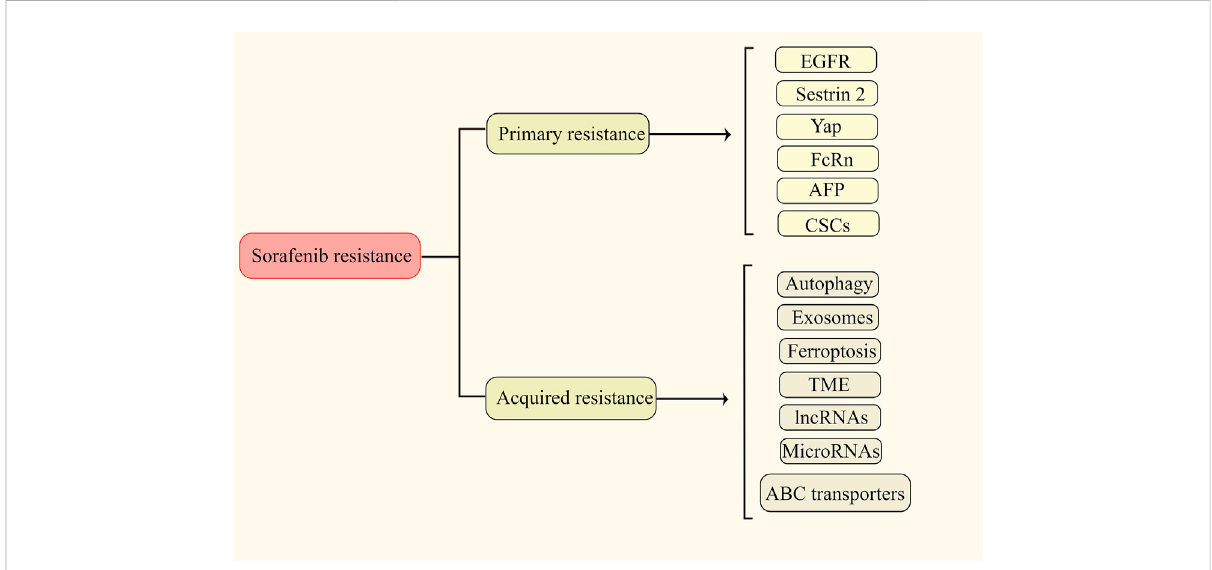
FIGURE 1 Major determinants of the primary and acquired resistance (edited by Figdraw